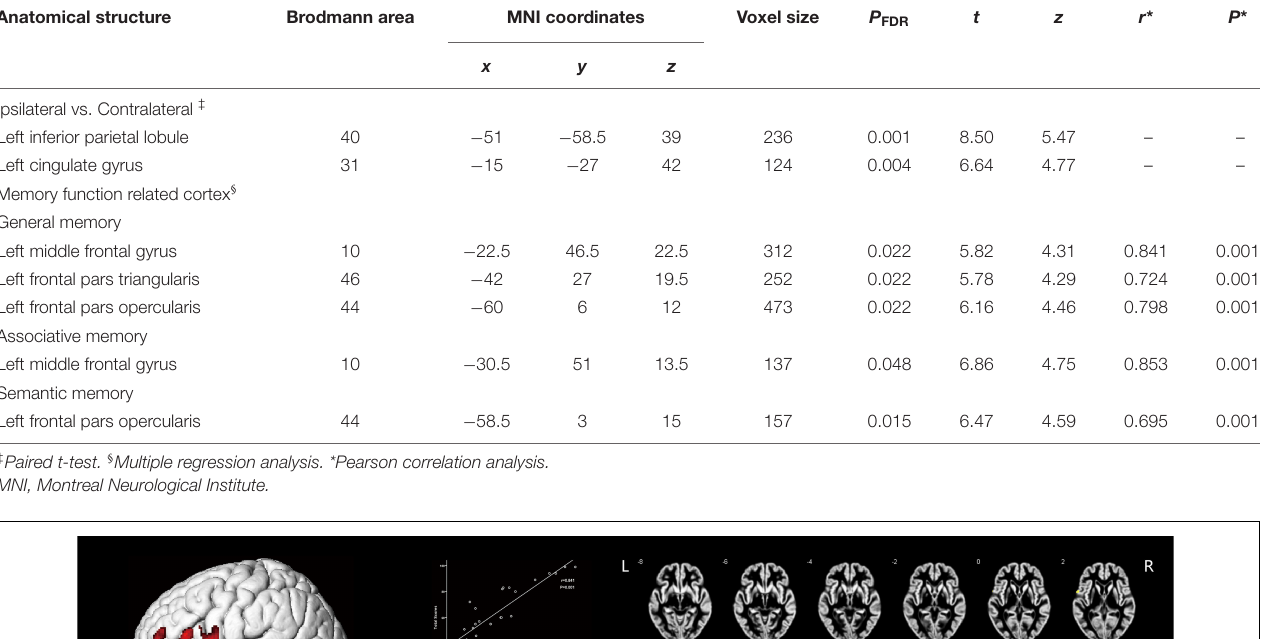
TABLE 5 | Details of gray matter regions reaching statistical significance in the ipsilateral and the contralateral comparison and memory function-related cortex. Anatomical structure